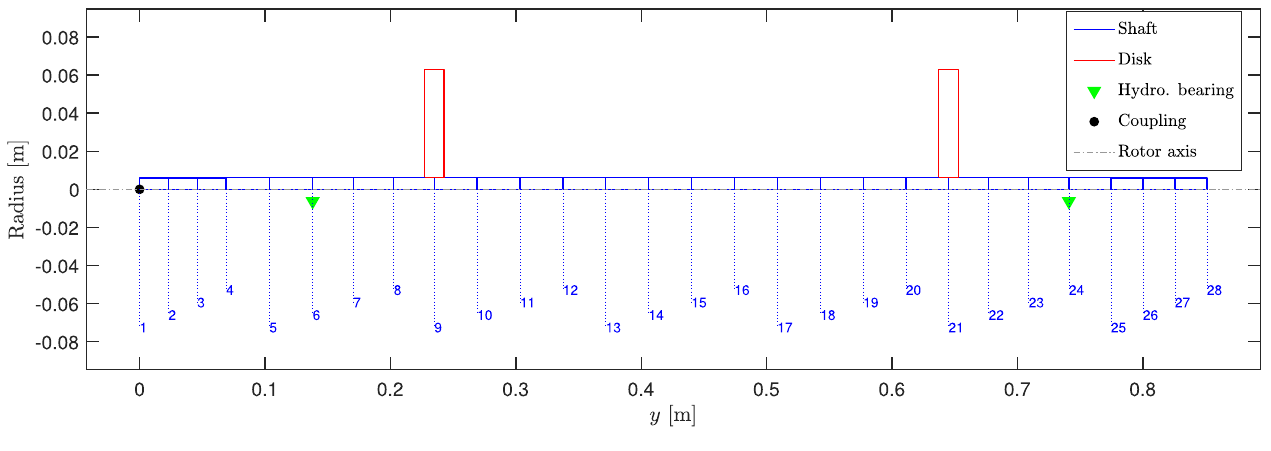
Fig. 3. On-board rotor FE mesh.